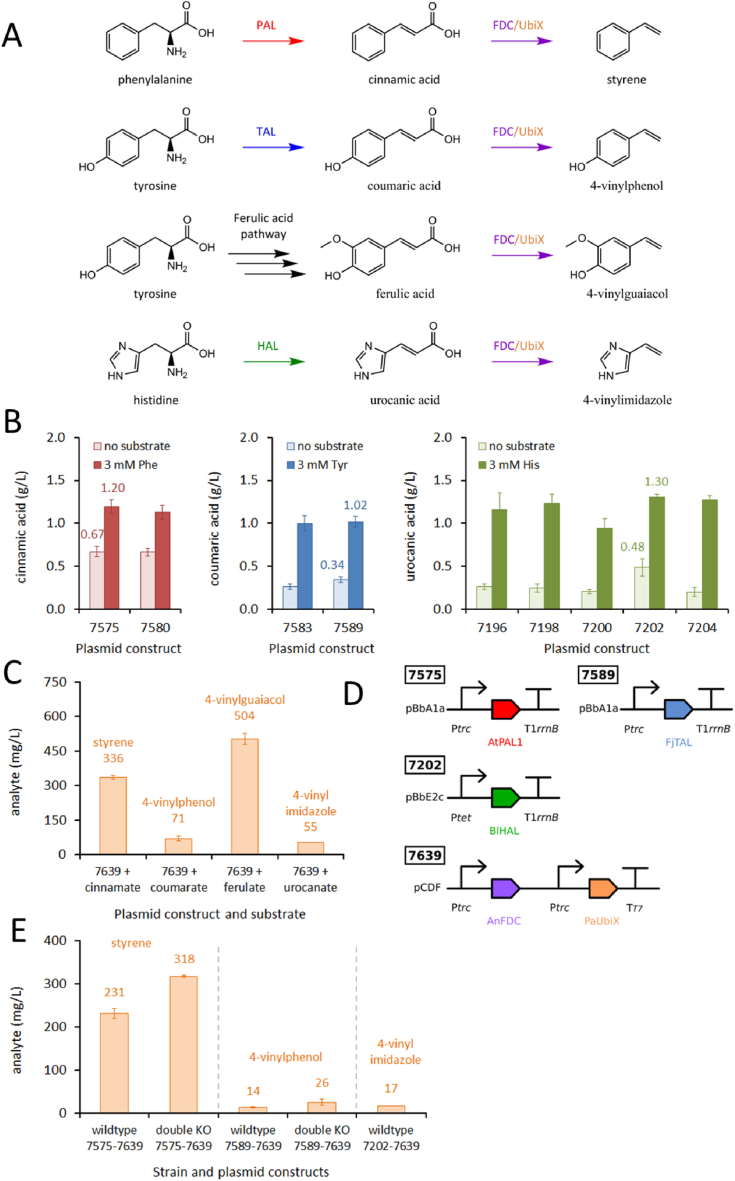
(A) Pathways from amino acid substrates to corresponding trans-phenylacrylic acid and vinylbenzene/vinylimidazole targets. Enzyme abbreviations: PAL (phenylalanine ammonia-lyase); TAL (tyrosine ammonia-lyase); HAL (histidine ammonia-lyase); FDC (ferulic acid decarboxylase); and UbiX (flavin prenyltransferase). (B) Screening of ammonia-lyase candidates. Enzymes were expressed in DH5α cells with or without 3 mM amino acid feed. AtPAL (Arabidopsis thaliana) expressed from pBbA1a (SBC007575) and pBbA5a (SBC007580) plasmids. FjTAL (Flavobacterium johnsoniae) expressed from pBbA1a (SBC007583) and pBbA5a (SBC007589) plasmids. HAL candidates expressed from the pBbE2c plasmid, from which SBC007202 (BlHAL, Burkholderia lata) was selected. (C) Screening AnFDC (Aspergillus niger) activity with PaUbiX (Pseudomonas aeruginosa) and various substrates. Both enzymes were expressed from Ptrc promoters on a pCDF plasmid in DH5α cells with 3 mM substrate feed. (D) Best performing plasmid constructs. (E) In vivo production of targets. DH5α wildtype and double knockout (ΔtyrR,ΔtyrA (styrene) or ΔtyrR,ΔpheLA (vinylphenol)) strains transformed with indicated plasmids and assayed after 24 h.